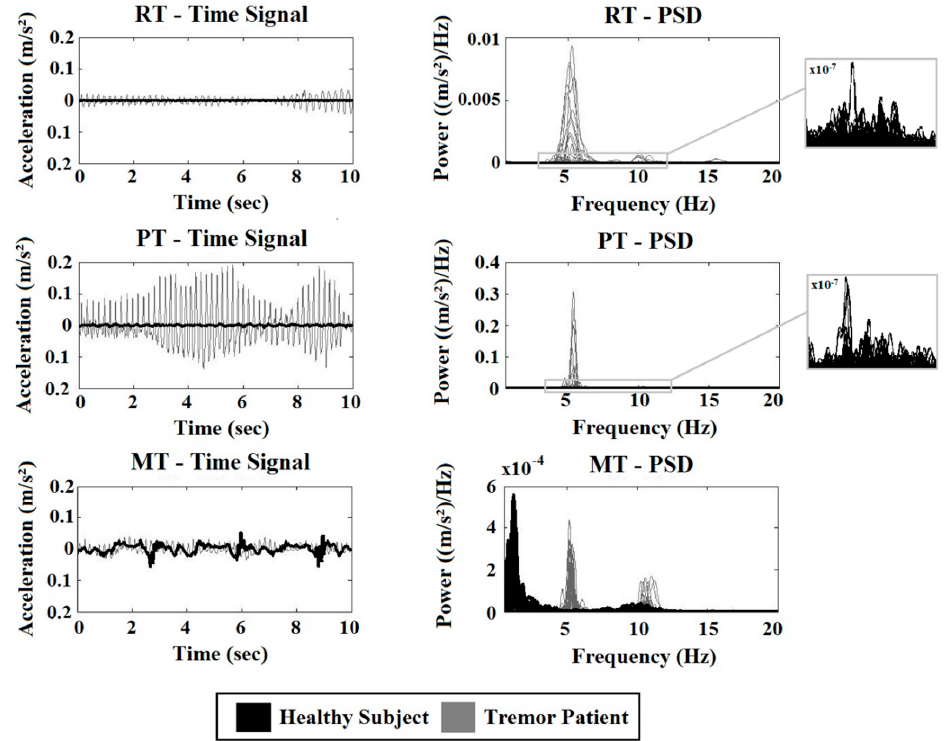
Figure 1. Time signals and corresponding power spectral densities (PSD) of a healthy control ( black ) and a tremor patient ( grey ). From top to bottom, data recorded during rest (RT), posture (PT), and movement (MT). On the right side, an enlargement of the PSD of the HC is given.